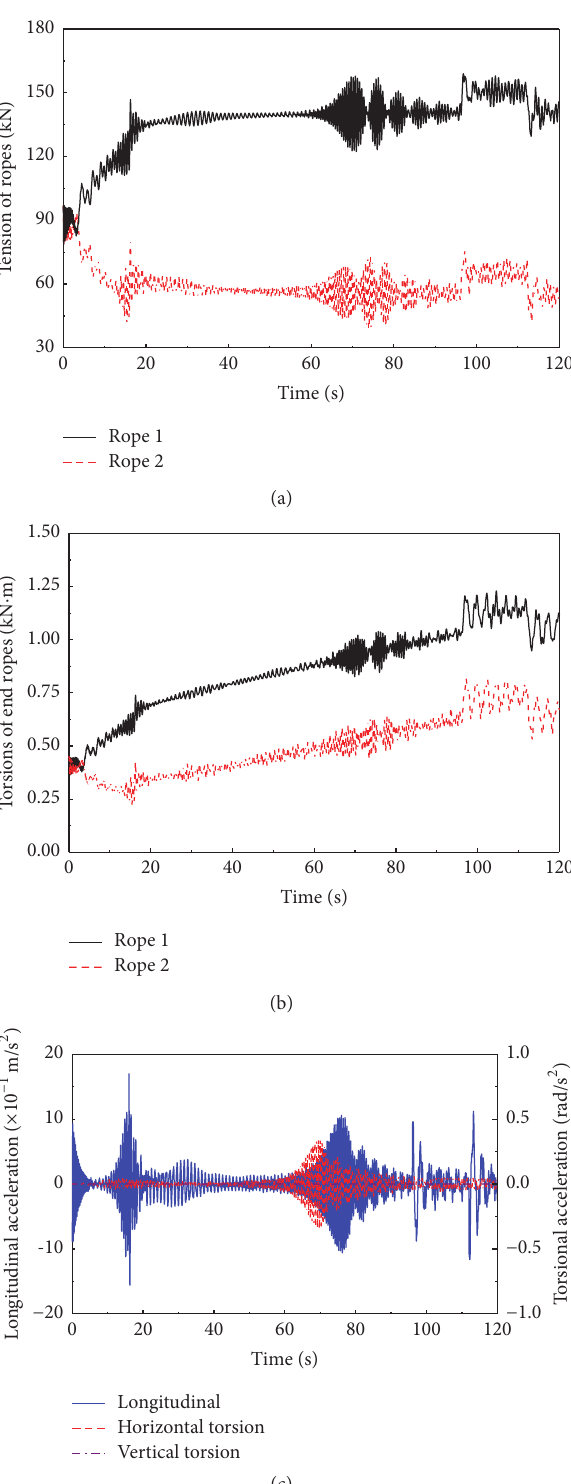
Figure 5: (a) Tensions, (b) torsions of the end ropes, and (c) accelerations of conveyance, calculated using 𝜉 = 0.0005